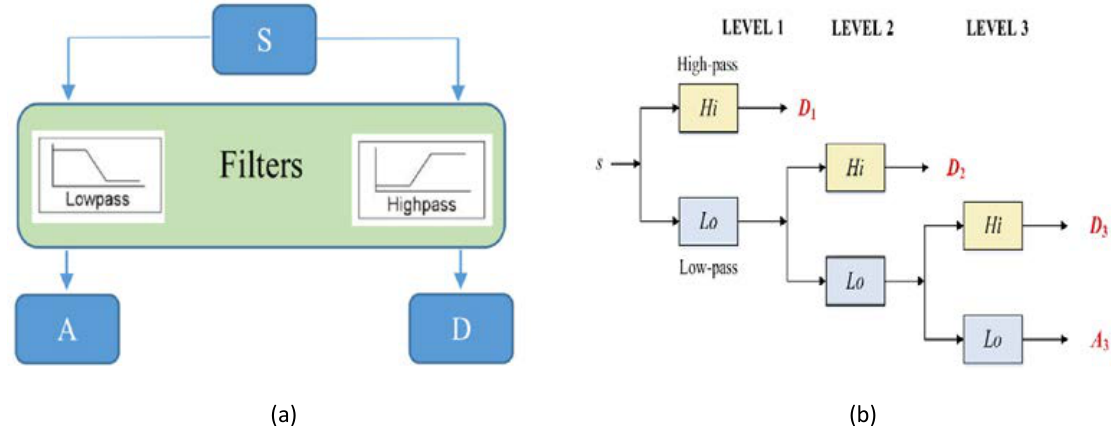
Fig. 3: a) Transformation of a discrete wavelet into approximation (A) and detail (D) segments; and b) multi-level decomposition of a signal at level 3